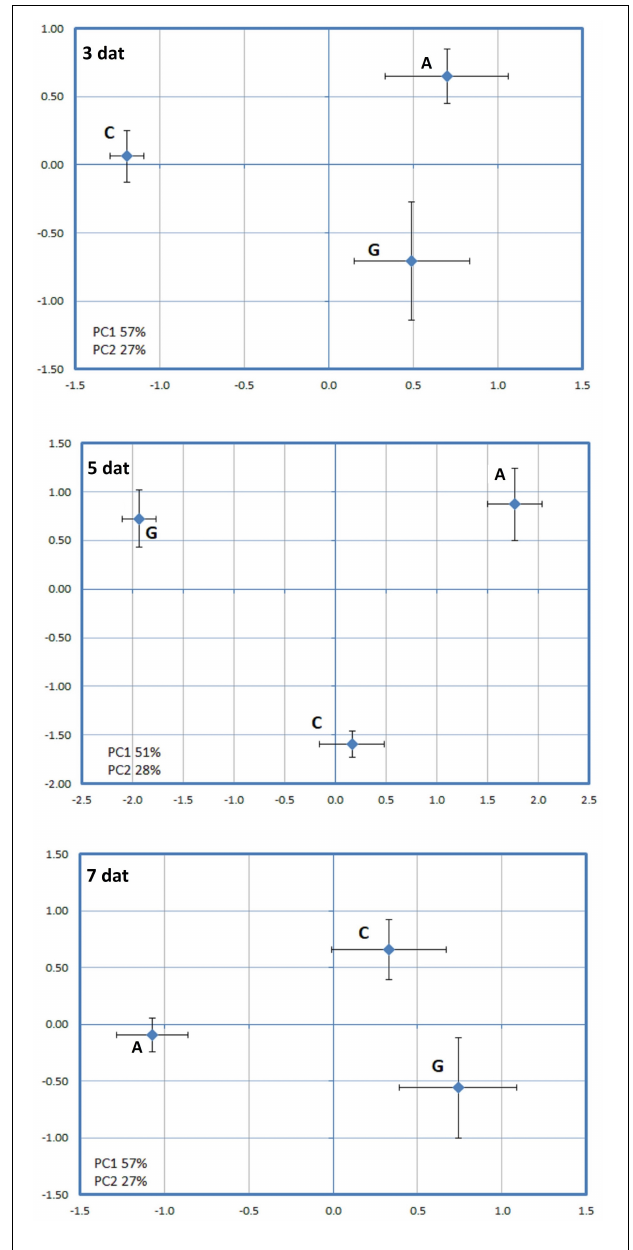
FIGURE 4 | Principal component analysis (PCA) performed for the spots whose volume significantly changed in abundance ( p -value < 0.05) between Greenforce CuCa (G), ASM (A), and Control (C) at 3, 5 and 7 days after